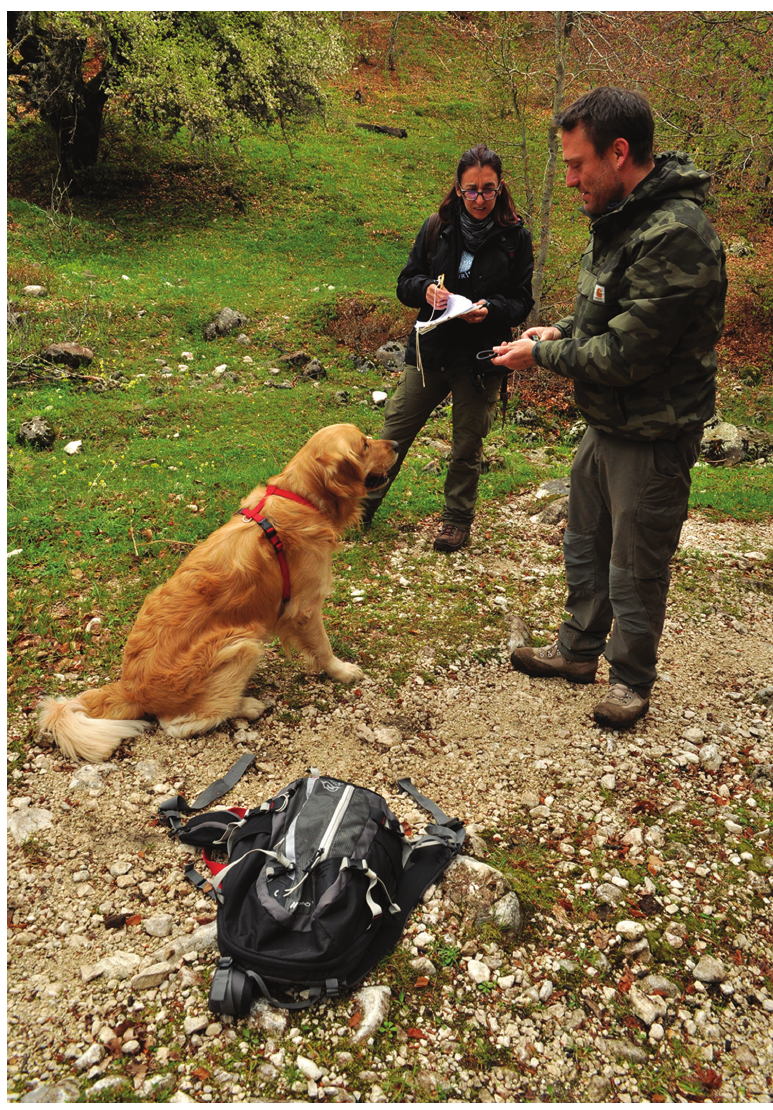
Figure 4. The CDD team: the dog, the handler and the field assistant ready for a working session (Photo by Emilia